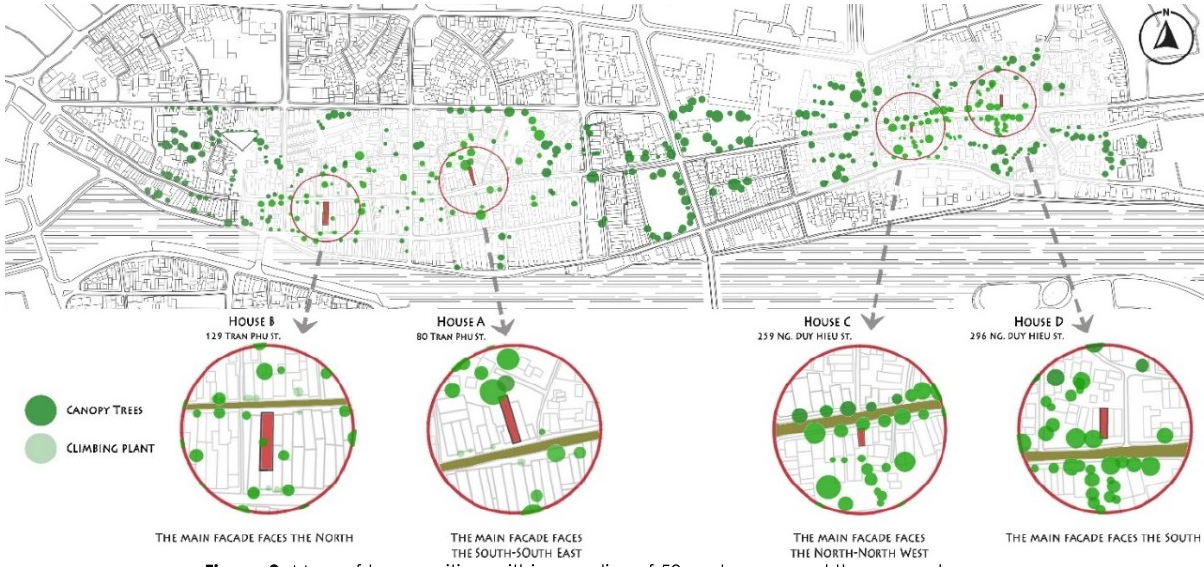
Figure 3. Map of tree position within a radius of 50 meters around the survey